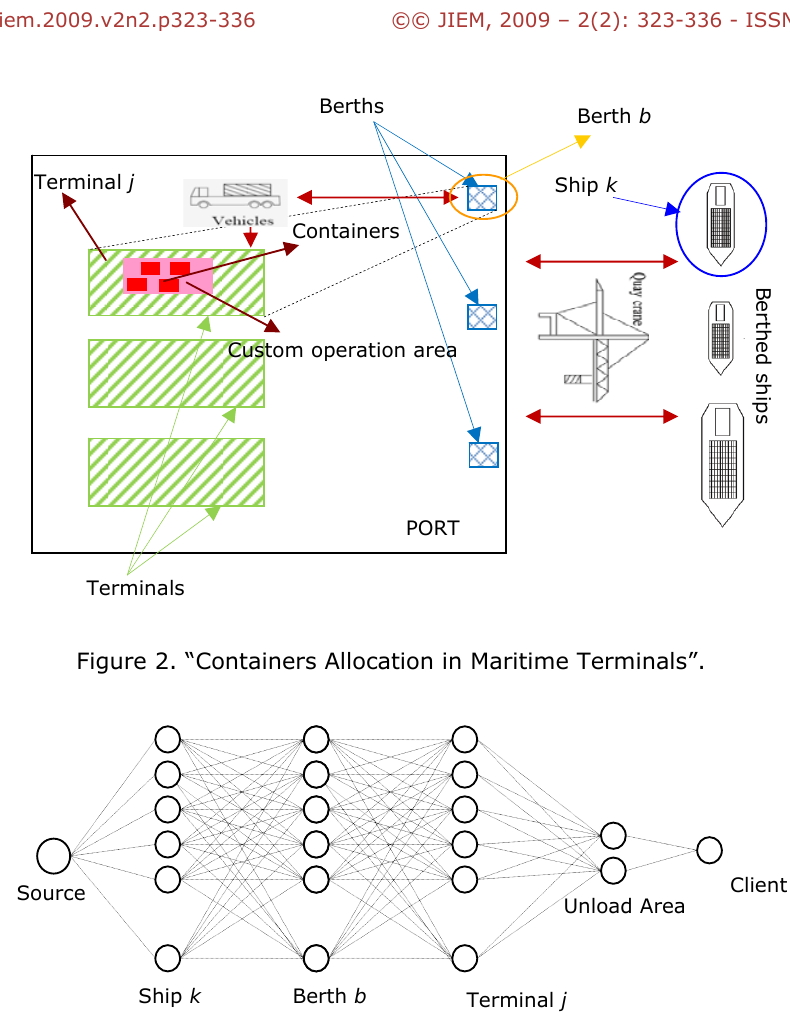
Figure 3. “Structure of Container Allocation